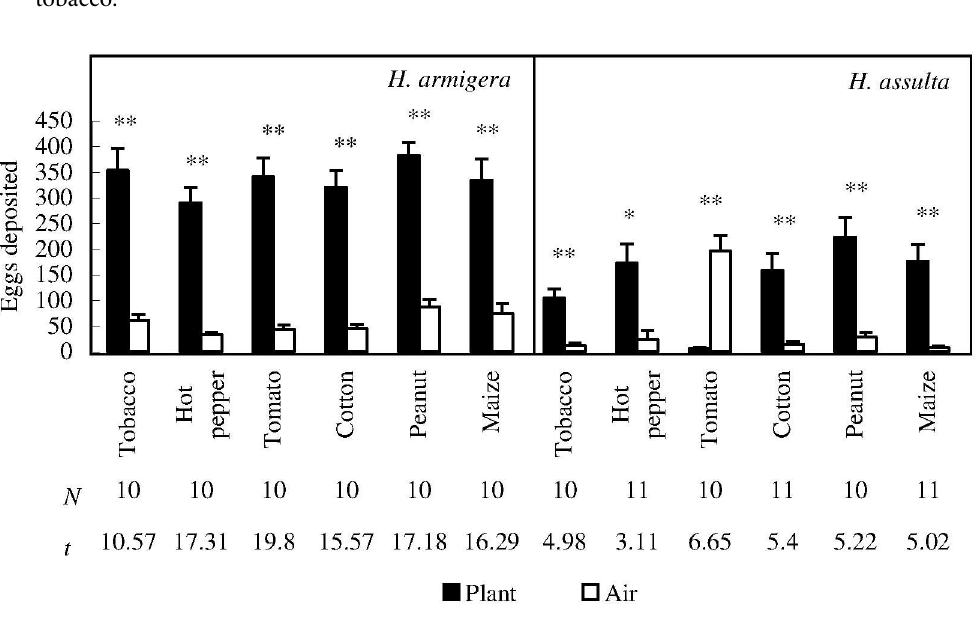
Fig 2. Ovipositional choice responses of H . armigera and H . assulta mated females under the conditions of each plant species paired with clean air. “ * ” and “ ** ” at the upper panel of the figure indicatesignificant difference within group at P = 0.05 and P = 0.01 levels, respectively, tested by paired t test. The values of “ N ” and “ t ” beneathrespective bars indicate replications and statistical t values,